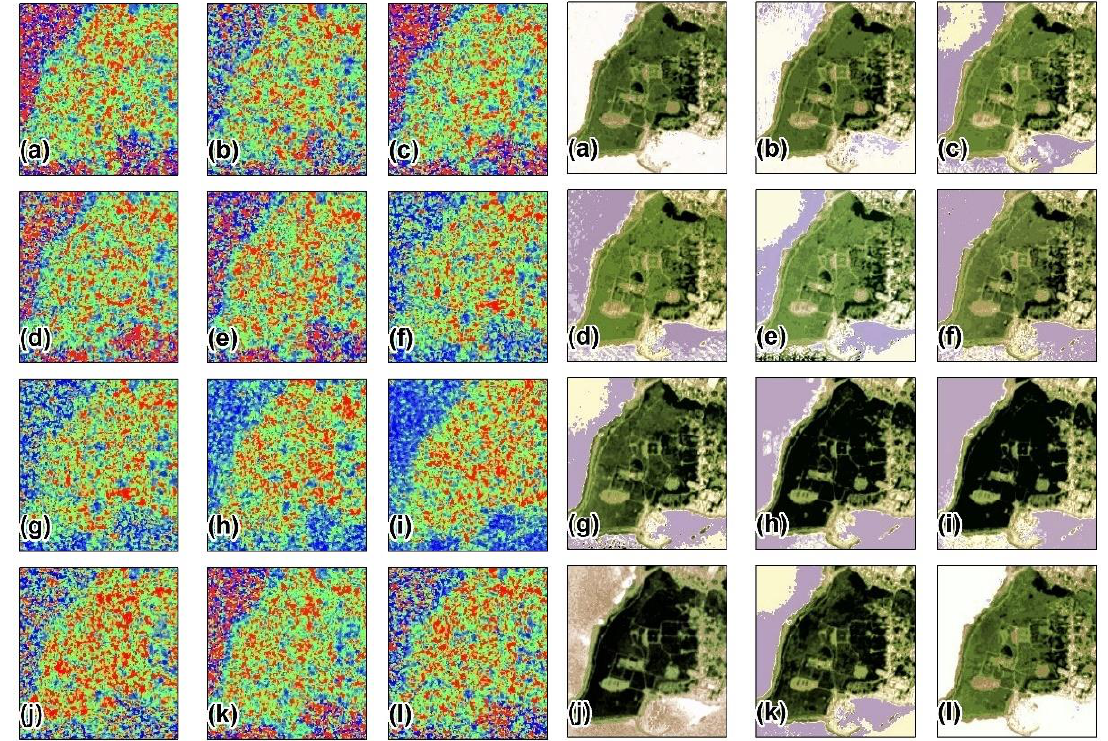
Figure 6. Monthly Radar Vegetation Index—RVI—(left) and Normalized Difference Vegetation Index—NDVI—results (right) ( a : May 2019, b : June 2019, c : July 2019, d : Aug. 2019, e : Sept. 2019, f : Oct. 2019, g : Nov. 2019, h : Dec. 2019, i : Jan. 2020, j : Feb. 2020, k : March 2020 and l : April